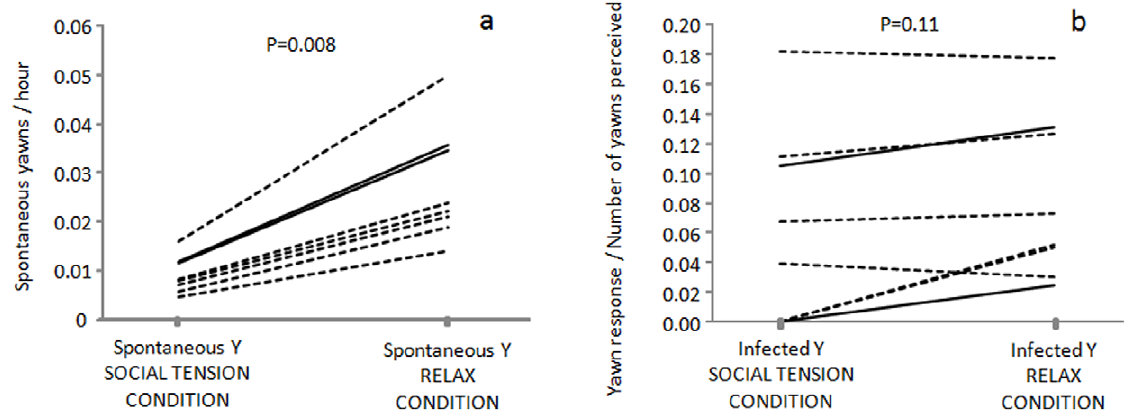
Figure 3. Individual hourly frequency of spontaneous yawns (a) and individual yawn response per number of yawns perceived (b) occurring under the two different social conditions: social tension (post-conflict, captive management, pre-feeding, and feeding) and relax (all the remaining periods of time) (see Methods for definitions). Dotted lines represent females, full lines represent males.